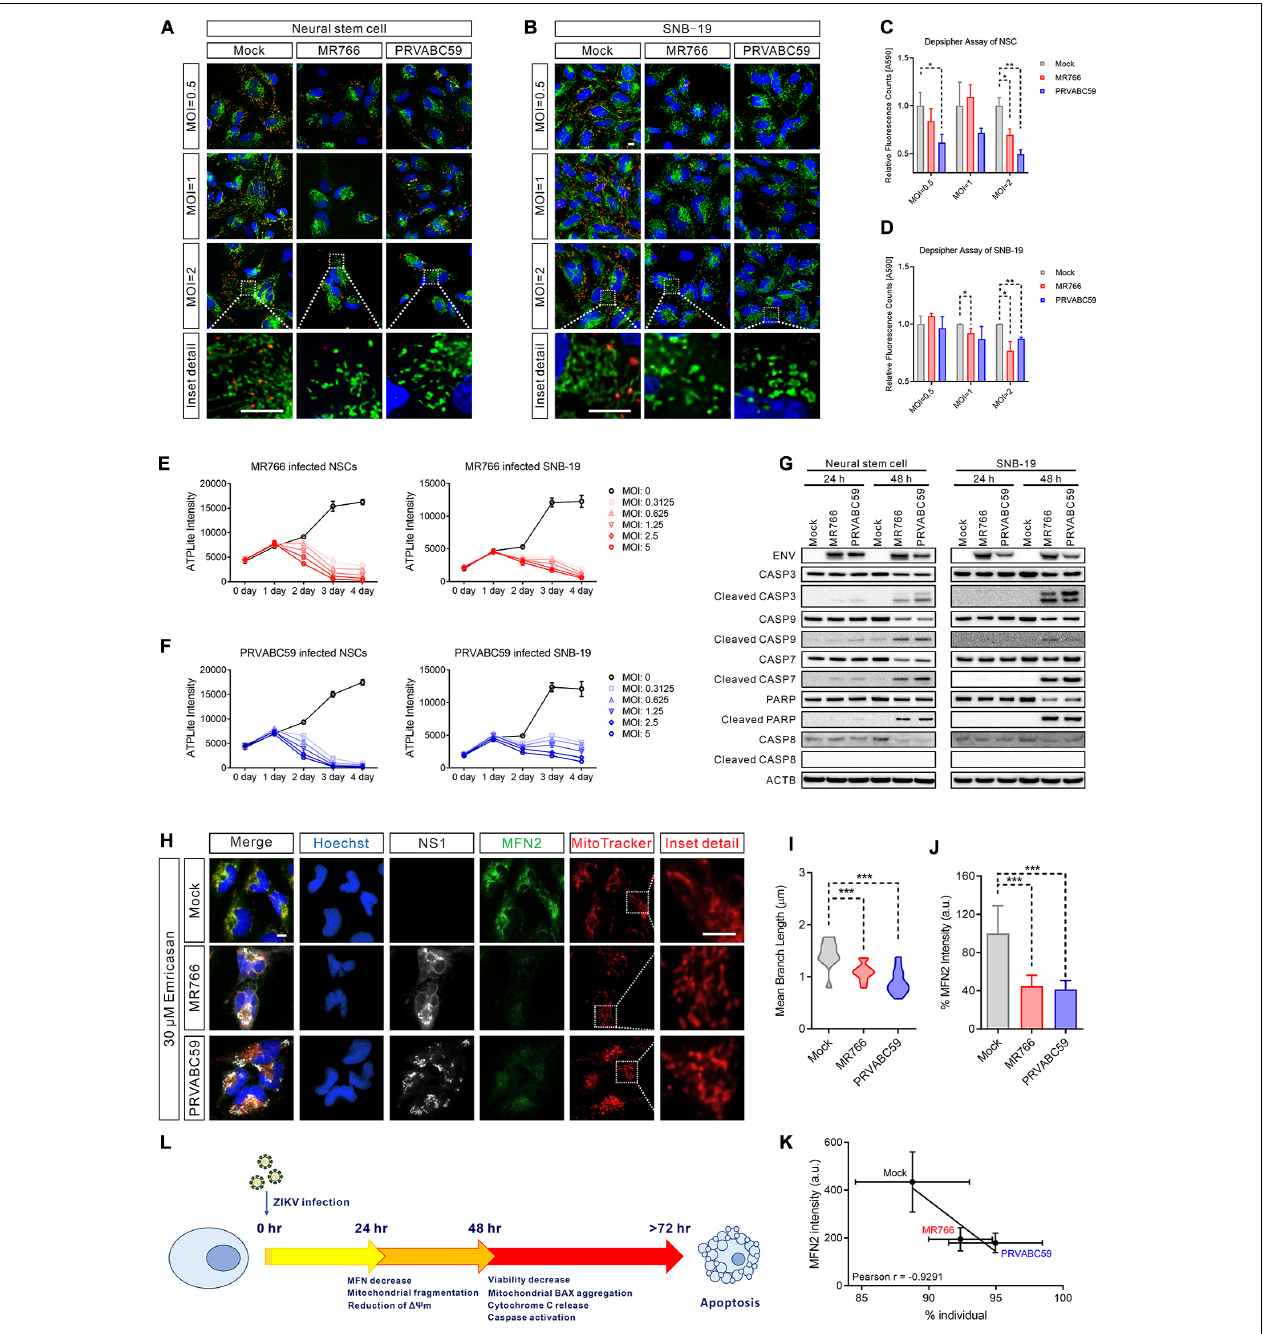
FIGURE 4 | ZIKV-induced mitochondrial fragmentation proceeded apoptosis. (A,B) DePsipher staining images of NSCs (A) and SNB-19 cells (B) 24 h after infection with ZIKV MR766 or PRVABC59 at various MOIs (0.5, 1, and 2). Green puncta indicate the DePsipher monomers in the mitochondria. Red puncta indicate the DePsipher aggregates in the mitochondria and normal membrane potential. Scale bar, 10 µ m. (C,D) Quantification of red puncta signal intensity in (A) and (B) , respectively. (E) Cell viability, as measured by intracellular ATP assay, of MR766 infected NSCs (left) and SNB-19 (right) at various MOIs (0–5). (F) Cell viability, as measured by intracellular ATP assay, of PRVABC59 infected NSCs (left) and SNB-19 (right) at various MOIs (0–5). (G) Western blot of ZIKV ENV, CASP3, cleaved CASP3, CASP9, cleaved CASP9, CASP7, cleaved CASP7, PARP, cleaved PARP, CASP8, and cleaved CASP8 of NSCs (left) or SNB-19 cells (right) at 24- or 48-h post-infection with ZIKV MR766 or PRVABC59 (MOI = 1). (H) Fluorescence images of SNB-19 treated with 30 µ M emricasan and infected with ZIKV MR766 or PRVABC59 for 24 h. Cells were then stained for MFN2 (green), ZIKV NS1 (white), nuclei (blue) and mitochondria (red). Scale bar, 10 µ m. (I) Violin plot of the mean branch length in (H) ( n = 12). (J) Quantification of immunostaining intensity of MFN2 in (H) ( n = 12). (K) Pearson correlation analysis shows the relationship between the percentage of mitochondrial individual and average MFN2 intensity in (H) . (L) A time-course schematic diagram of cells after ZIKV infection. P -values were calculated by two- tailed Student’s t -test (C,D) or one-way ANOVA with Tukey’s multiple-comparison test (I,J) . ∗ p < 0.05, ∗∗ p < 0.01, and ∗∗∗ p < 0.001.